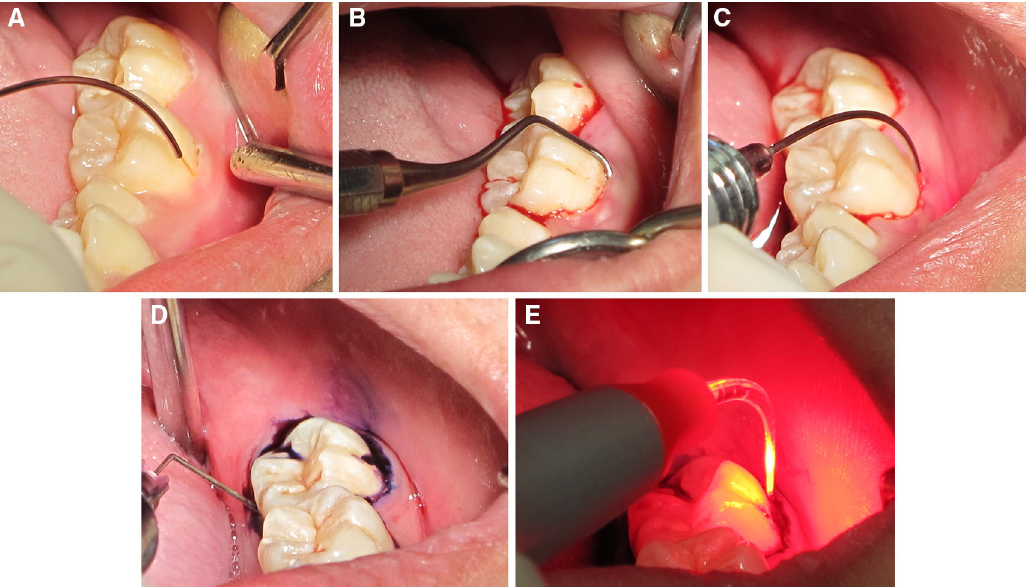
Figure 7. The LANAP procedure. A. The 980 nm diode laser was used for dilating the gingival sulcus. B. Scaling and rootplanning withhandinstruments. C.The 980nmdiodelaserwasused for ablatingthe longjunctionalepithelium and granulation tissue in the gingival sulcus. D. Toluidine blue was injected as a photosensitizer into the gingival sulcus. E. The gingival sulcus was irradiated with a 635 nm diode laser via a 200-micron flexible tip to initiate photosensitizer.